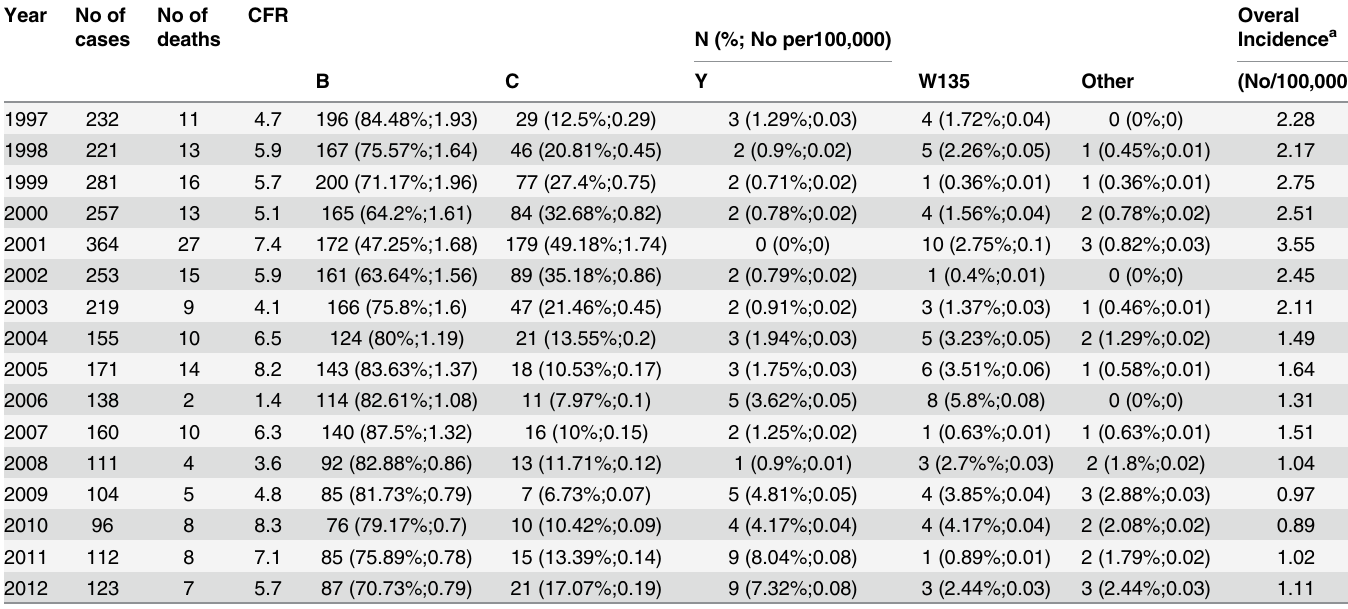
a Population data obtained from: http://statbel.fgov.be/nl/statistieken/cijfers/bevolking/structuur/leeftijdgeslacht/belgie/ Serogroup C vaccination period 2001 – 2004.